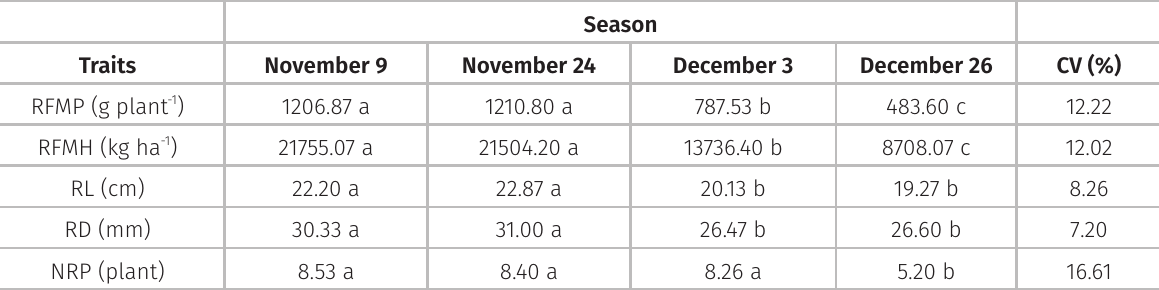
Table III. Root fresh matter per plant (RFMP (g plant −1 ) and hectare (RFMH, kg ha −1 ), root length (RL), root diameter (RD), and number of roots per plant (NRP) in cassava plants transplanted on November 9 and 24 and December 3 and 26.